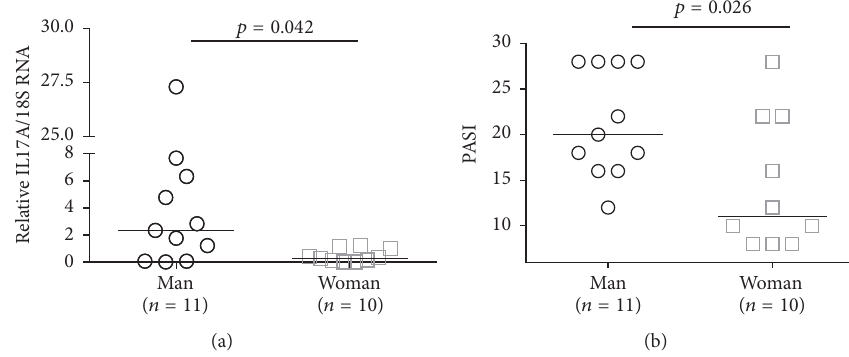
Figure 2: Different IL17A biopsy profile expression (a) and disease severity (b) between man and